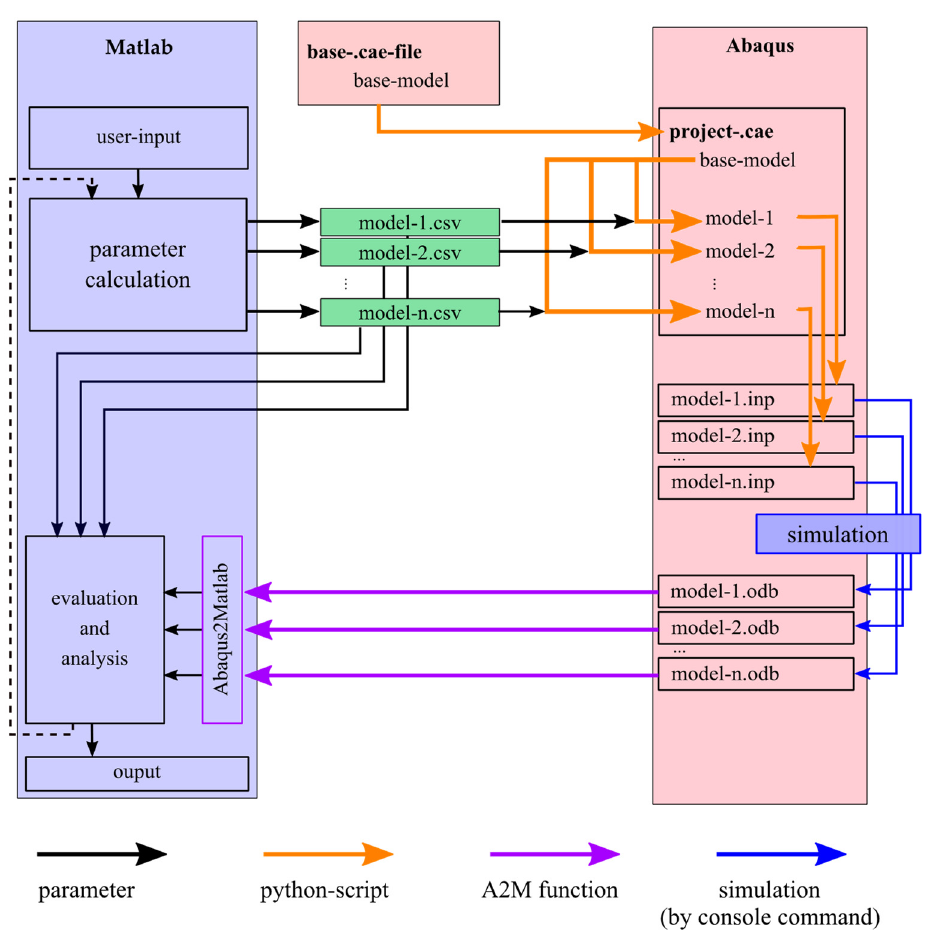
Figure 5. Development environment of the parameter study.